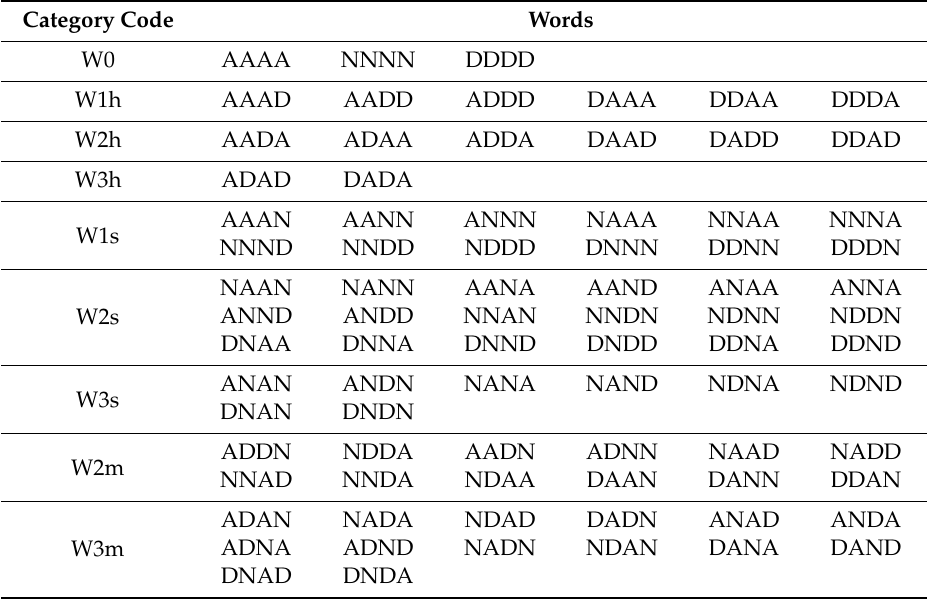
Table 1. Classification of all di ff erent words of length four by nine category